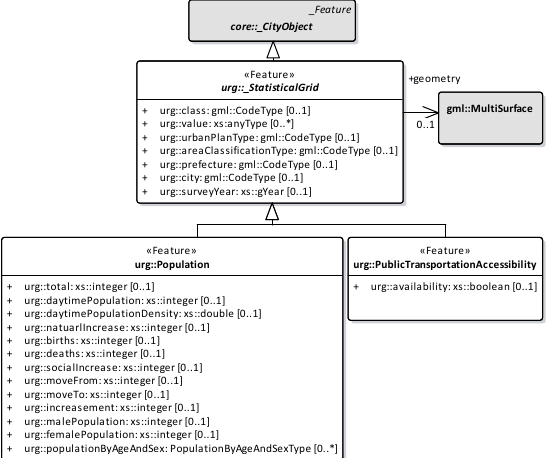
Figure 7. A part of the UML class diagram of the Statistical Grid Module